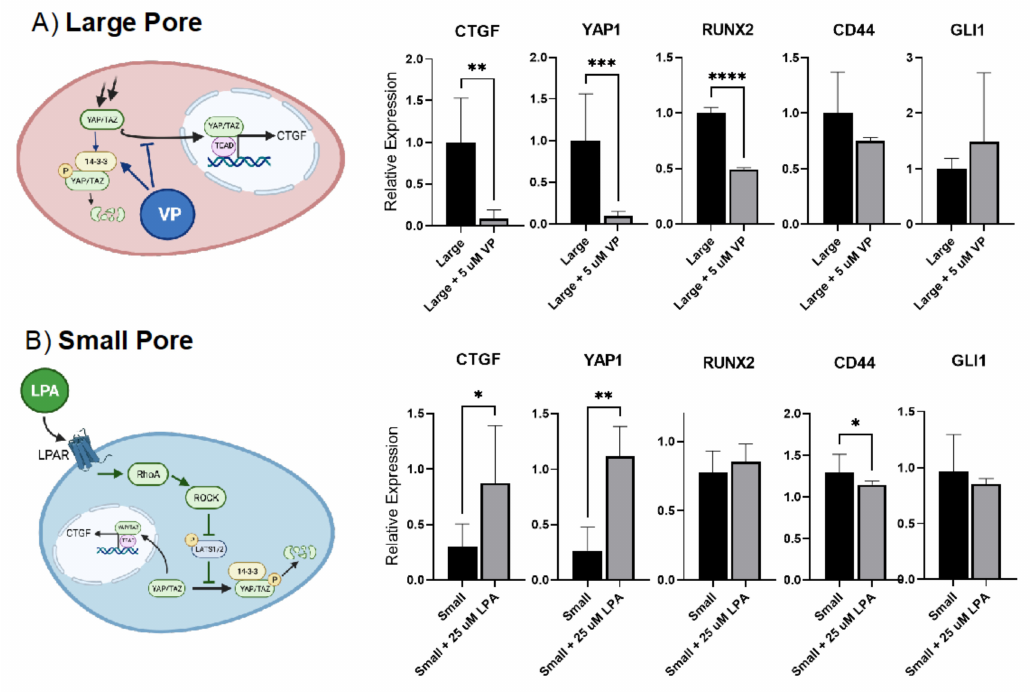
Figure 11. Quantitative real time polymerase chain reaction assessment of gene expression in scaffold- constructs after 5 days culture with pharmacologic modulators of YAP by verteporfin (VP, 5 µ M, ( A )) or lysophosphatidic acid (LPA, 25 µ M, ( B )), compared to vehicle control. * = p < 0.05, ** = p < 0.01, *** = p < 0.001, **** = p <